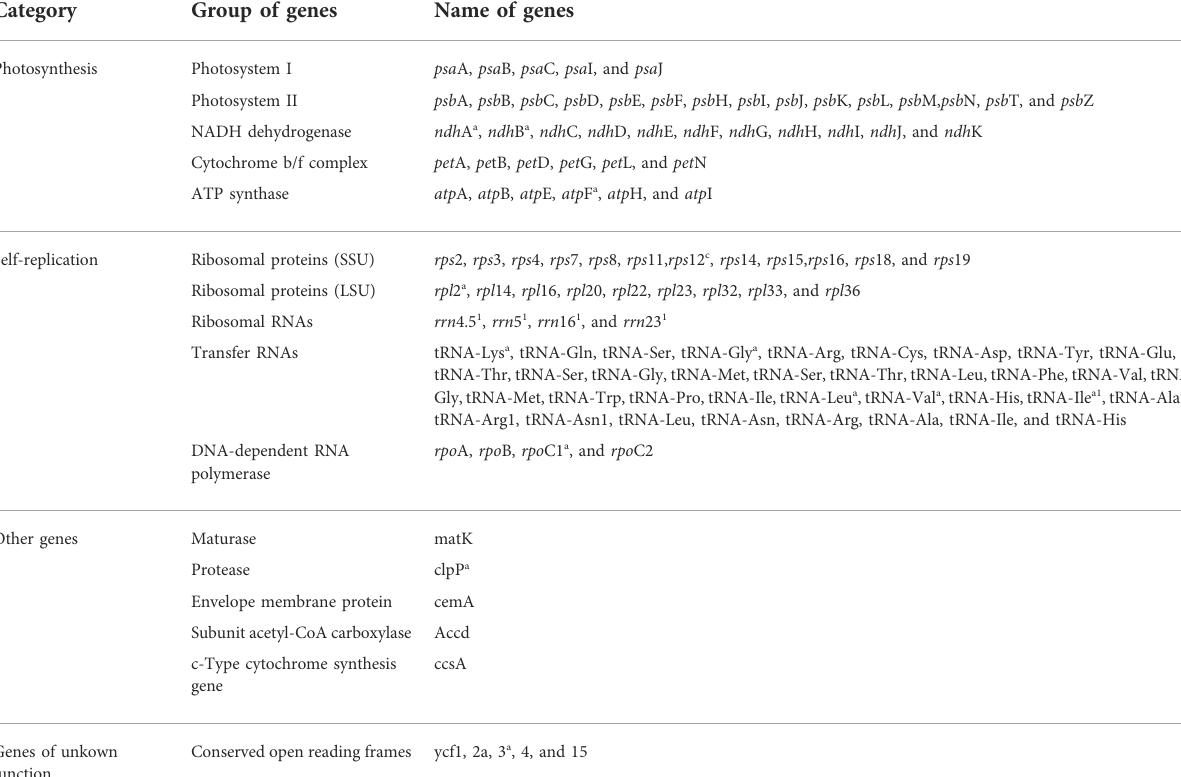
TABLE 2 Gene composition of chloroplast genome of all Swertia L.